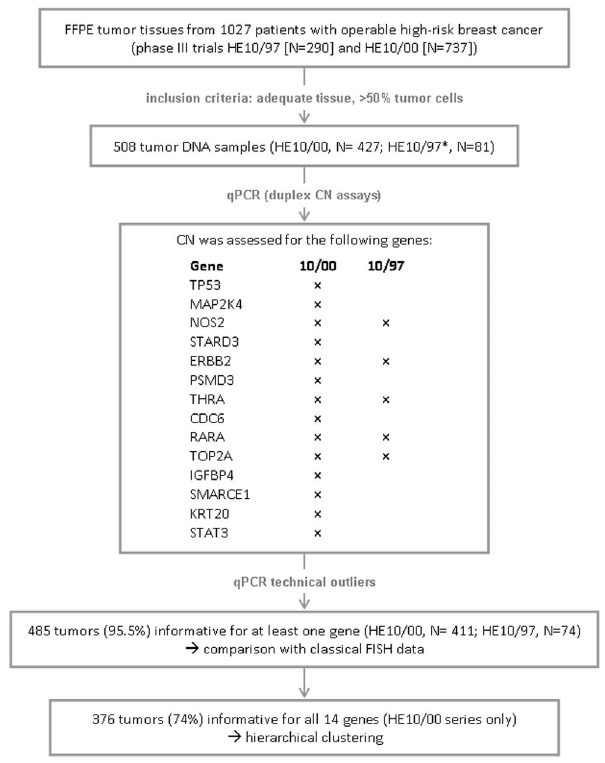
Figure 1. REMARK flow chart. *: for the majority of HE10/97 cases tissue material was exhausted while for the 81 cases from the same series the amount of available DNA was sufficient for a limited number of genes